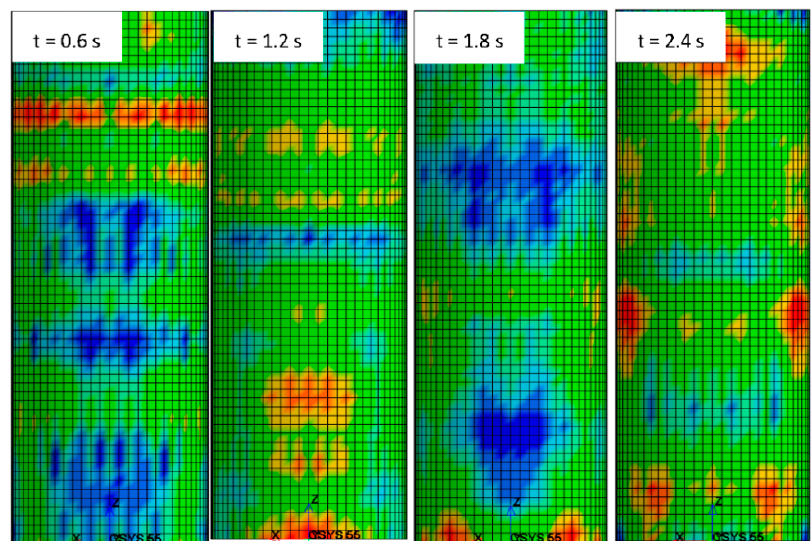
Figure 18. The contour of the radius-displacement when the thickness is 0.01 m, P12.